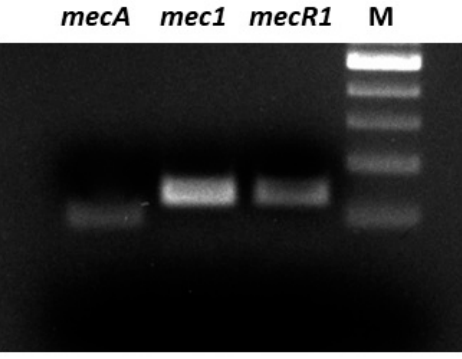
Figure 1. Detection of genes from mec operon in methicillin-resistant S. pseudintermedius (MRSP) M: 100bp ladder marker (Biotech Rabbit). strain. M: 100bp ladder marker (Biotech Rabbit).